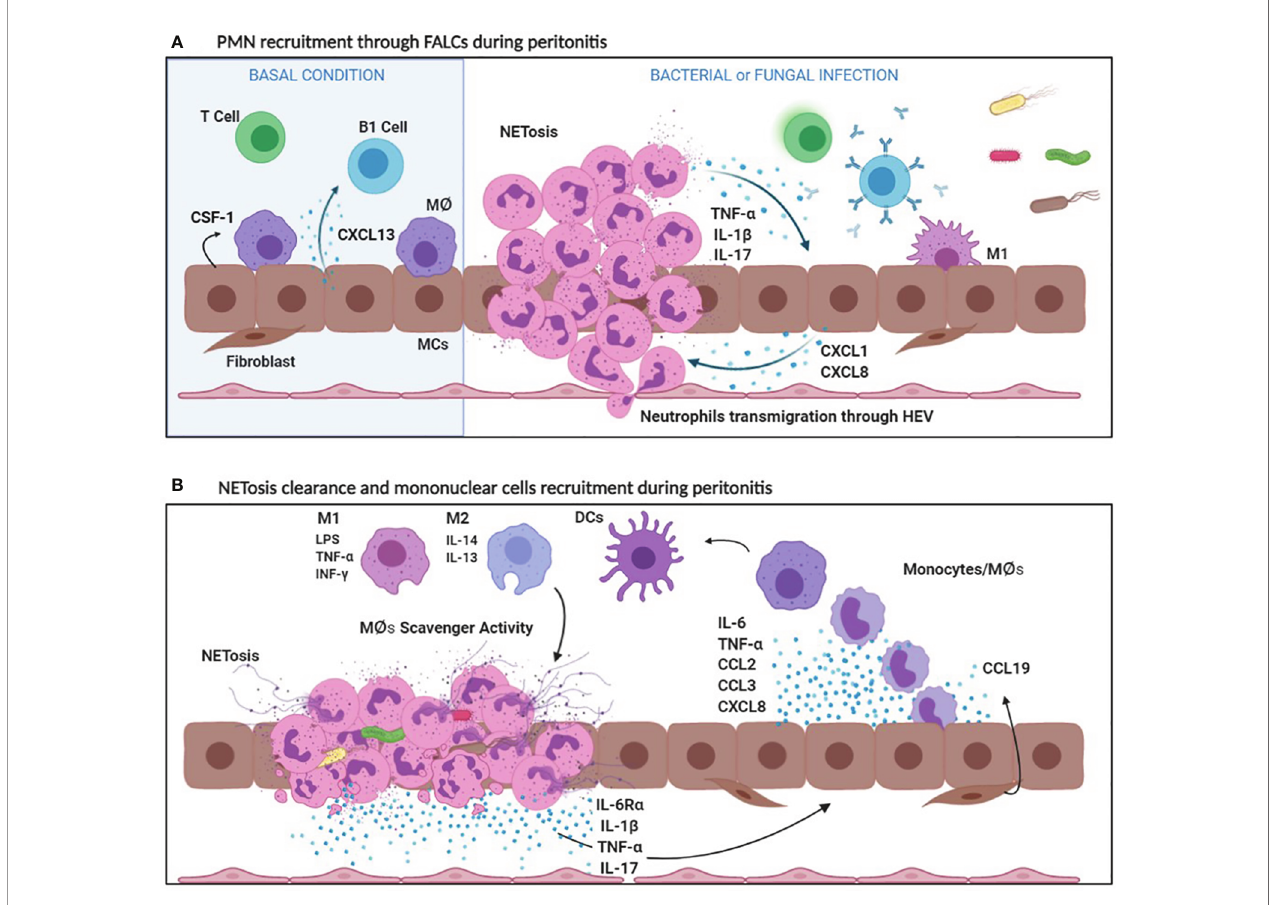
FIGURE 2 | (A) PMN recruitment through FALCs during peritonitis. In basal conditions, MCs secrete CXCL13, which attracts B1 cells in FALCs and CSF1, a speci fi c MØ growth factor. Bacterial and fungal infections stimulate the production of CXCL1 and CXCL8, by MCs. Bacterial products, CXCL1 and CXCL8 promote the recruitment of a fi rst wave of PMNs entering the peritoneal cavity through FALCs. PMNs cause an initial in fl ammatory response secreting in fl ammatory cytokines (IL-1ß, TNF- a ). Afterwards, NETosis helps in sequestering microorganisms in FALCs. (B) NETosis clearance and mononuclear cell recruitment during peritonitis. Bacterial products, as well as IL-1ß, stimulate the production of IL-6, TNF- a , CCL2, CCL3, and CXCL8 by MCs. IL-6Ra shedding by PMNs promotes a peripheral IL-6 response (transignaling). Cytokines and chemokines released during the in fl ammatory process favor mononuclear recruitment and differentiation. Mononuclear phagocytes differentiate in Macrophages (MØs) and dendritic cells (DCs). Among MØs, M1 subtype is endowed with pro-in fl ammatory and cytotoxic properties, whereas M2 MØs have an anti-in fl ammatory activity. Moreover, M2 MØs play a key role in the clearance of neutrophils debris due to scavenger